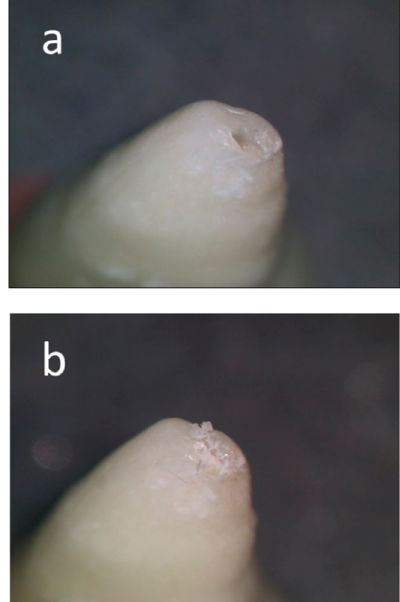
Figure 1. Apical extrusion of debris. During root canal treatment, debris consisting of necrotic tissue, bacteria and dentin particles is often extruded through the apical foramen and into the periapical tissues. Such debris may cause severe response (“flare up”) and may jeopardize the long-term success of the root canal treatment. ( a ) Tip of the root with an apical foramen. ( b ) Debris extruded through the apical foramen during instrumentation of the root canal.